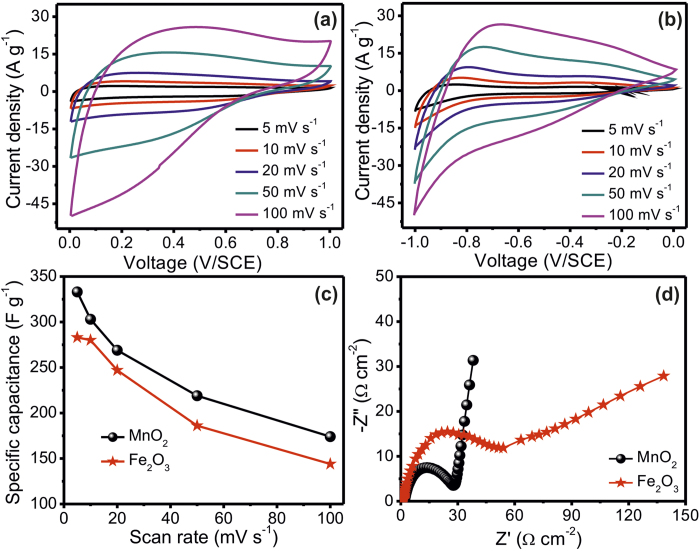
Cyclic voltammograms of(a) MnO2 and (b) Fe2O3 electrodes at different scan rates, (c) plots of specific capacitance versus potential scan rate. (d) Nyquist plots of MnO2 and Fe2O3 electrodes.